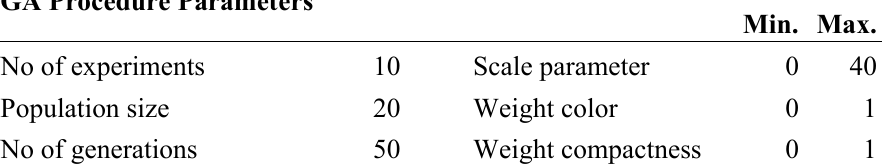
Table 2. Genetic algorithm parameters and search space defined for the experiments with images 1 to